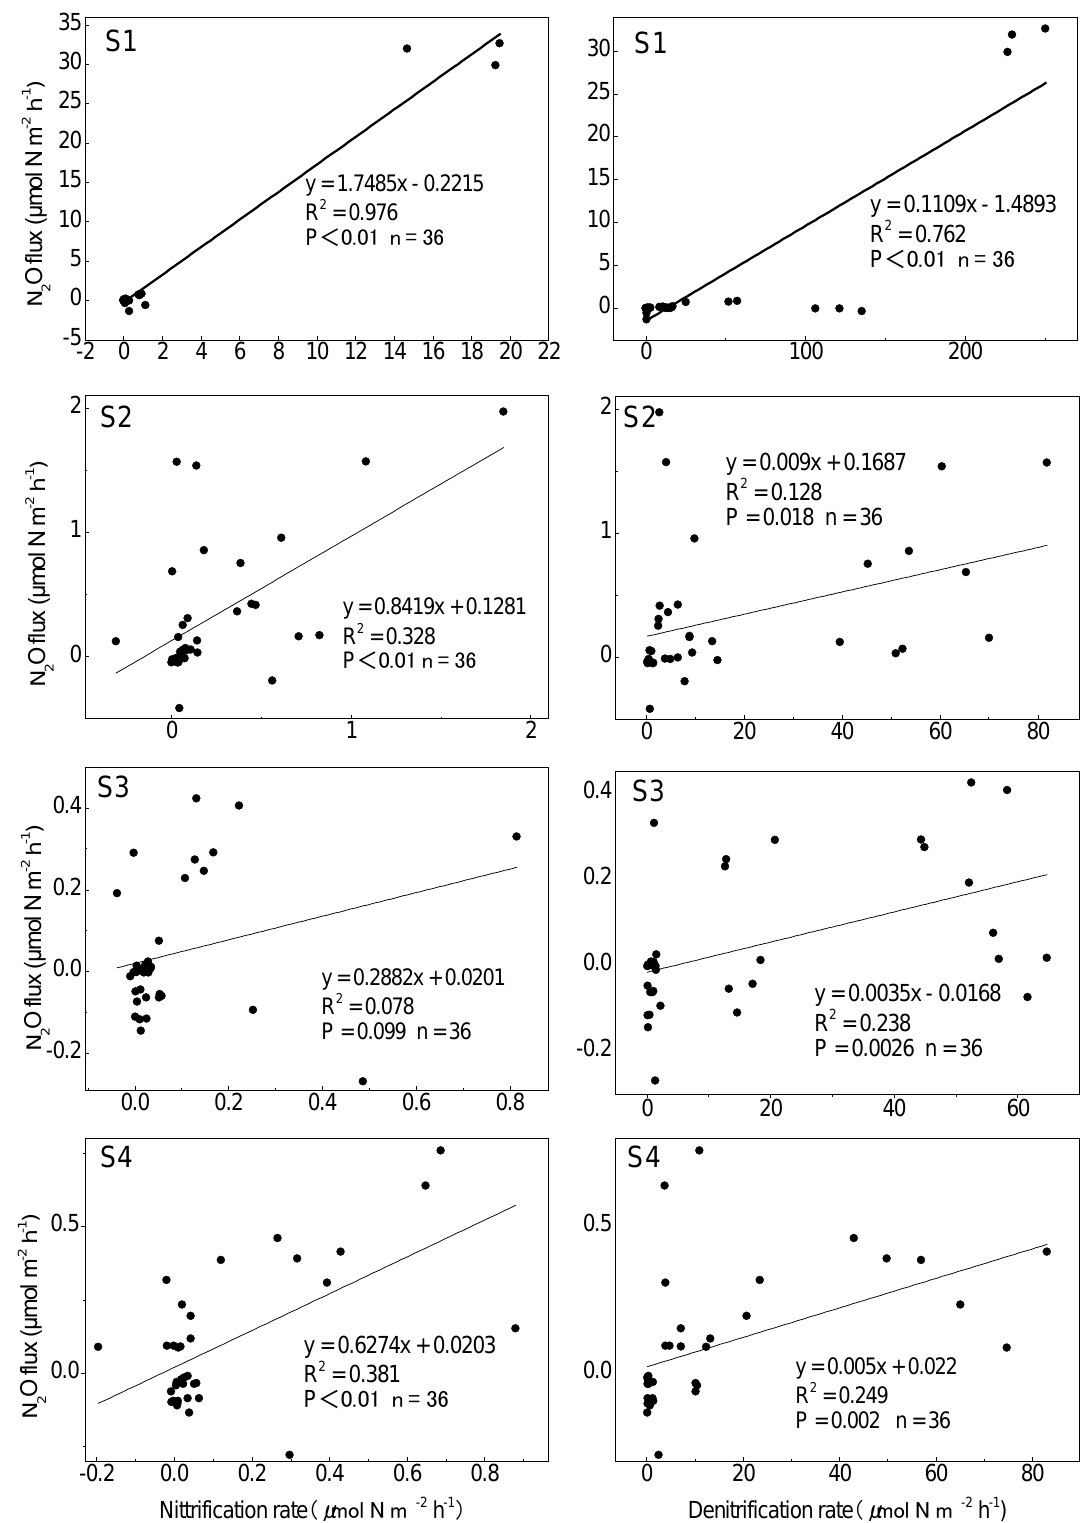
Figure 4. Relationships between nitrification and denitrification rates and N 2 O flux at the sediment–water interface, including the regression equation, the sample number ( n ), and the coefficient of determination ( R 2 ), accompanied by p values, at each site.